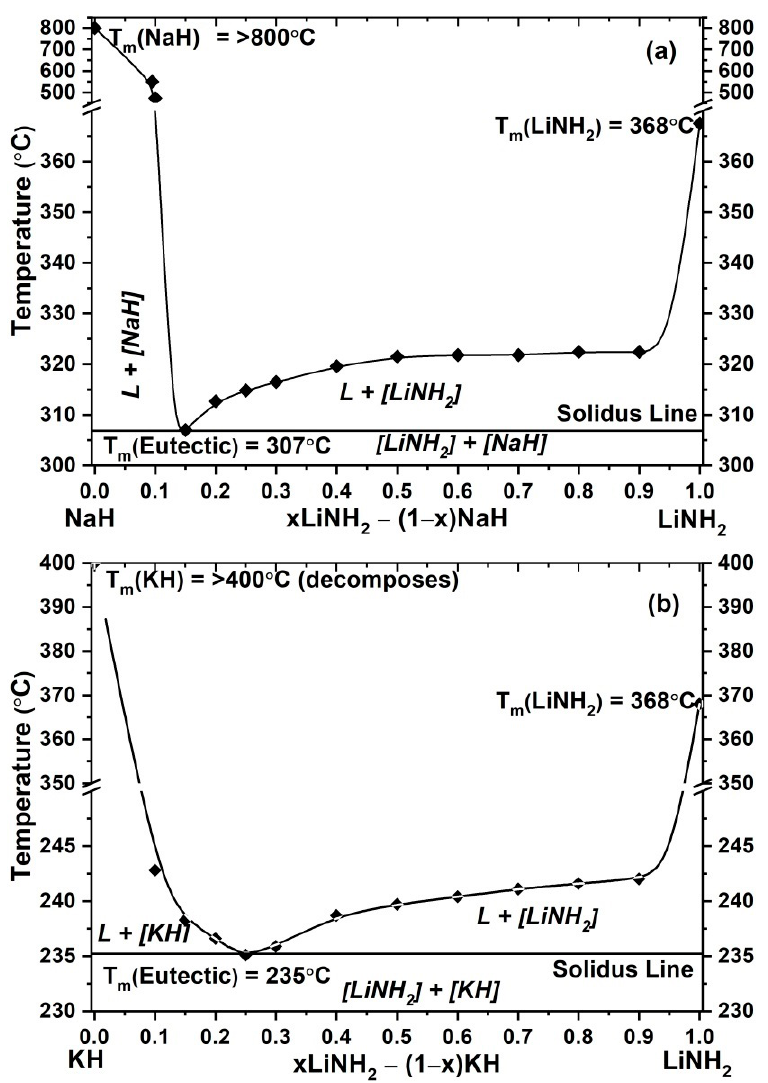
Figure 7. Phase diagram of LiNH 2 -NaH ( a ) and LiNH 2 -KH ( b ) system. Consideration of onset temperature as melting point has been taken. (L represents the melted state in the figure).